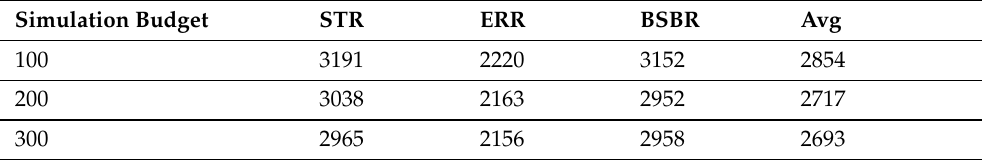
Table 5. Average performance comparison of simulation